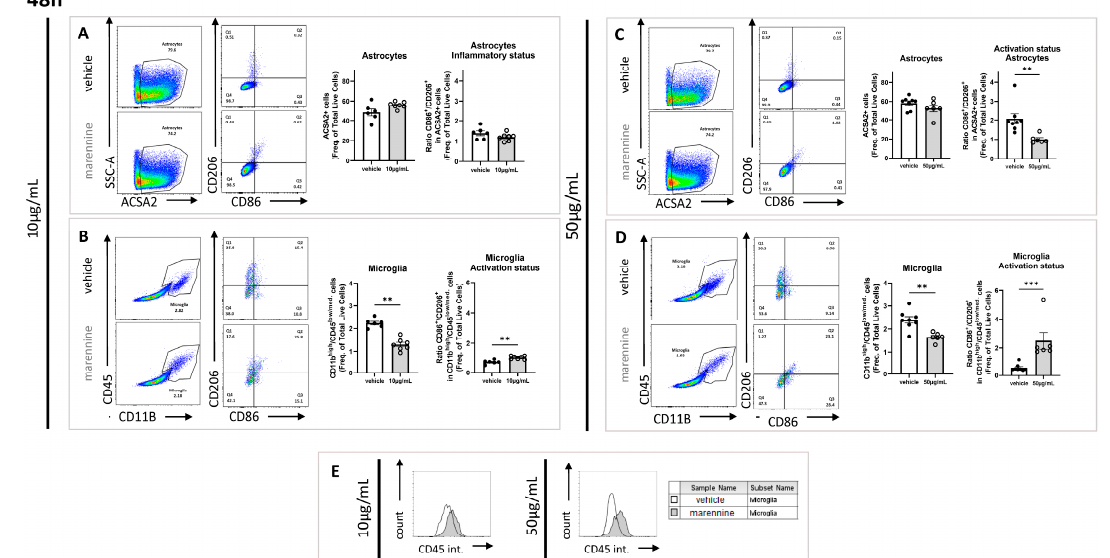
Figure 4. Effects of 10 and 50 µ g/mL of marennine in astrocytes and microglial cells after 48 h of exposure. ( A ) Astrocytes were gated as ACSA2 positive; activation status was determined through CD86 and CD206 staining after exposure to marennine at 10 µ g/mL. ( B ) Microglial cells were gated as CD11b high and CD45 low/medium; activation status was determined through CD86 and CD206 staining after exposure to marennine at 10 µ g/mL. ( C ) Astrocytes were gated as ACSA2 positive; activation status was determined through CD86 and CD206 staining after exposure to marennine at 50 µ g/mL. ( D ) Microglial cells were gated as CD11b high and CD45 low/medium; activation status was determined through CD86 and CD206 staining after exposure to marennine at 50 µ g/mL. ( E ) Quantification of CD45 intensity after a marennine of 10 µ g/mL (left) and 50 µ g/mL (right). For 24 h, at 10 µ g/mL vehicle n = 6, marennine n = 7. At 50 µ g/mL vehicle n = 8, marennine n = 6. Values represent mean ± SEM. Statistically differences from control are indicated as follows: ** p < 0.01: *** p < 0.001 using Mann-Whitney